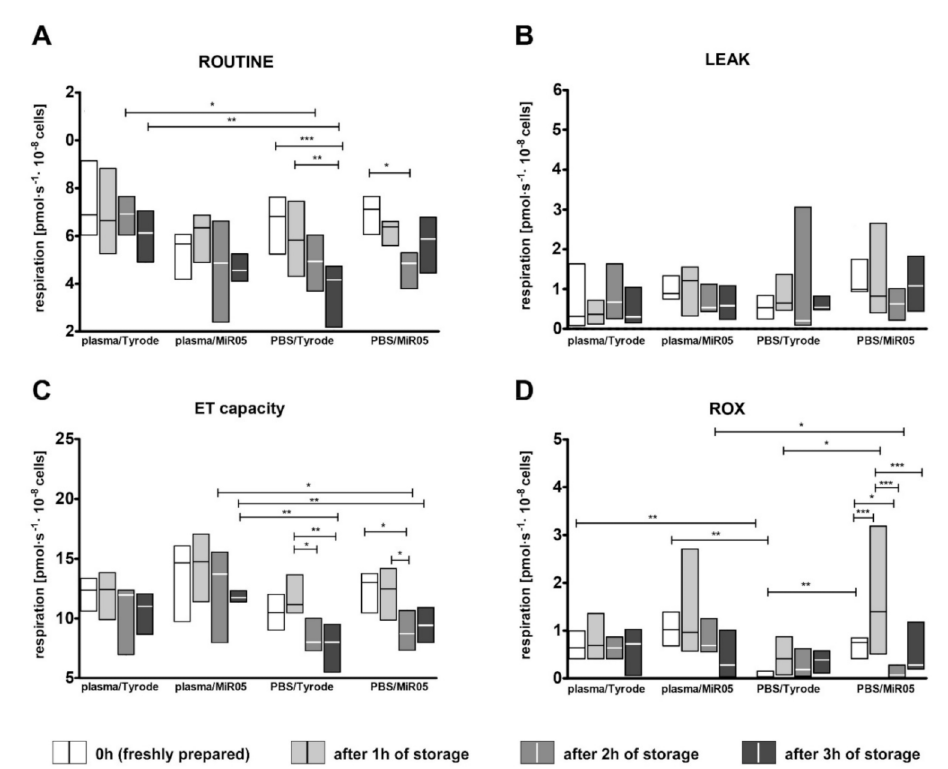
Figure 4. The effect of the storage of the platelet suspension on platelet mitochondrial and non-mitochondrial respiration in samples suspended in plasma or PBS and transferred to MiR05 or Tyrode’s buffer at the appropriate time point of storage. Data are presented as medians (solid line within boxes) and IQRs (boxes); n = 6. ROUTINE respiration ( A ), LEAK ( B ), ET capacity ( C ), and ROX ( D ) were measured for freshly prepared platelet suspensions and after one, two, and three hours of storage. The significance of differences, as estimated with two-way ANOVA for repeated measures with post hoc Tuckey test was: * p < 0.05, ** p < 0.01, *** p < 0.001. Additional information on the effect of time, the effect of medium and the effect of buffer are presented below: ( A ) p < 0.01 for the effect of time, p < 0.01 for the medium-depended buffer effect, ns. for the effect of medium, ns. for the effect of buffer; ( B ) ns. for the effect of time, ns. for the effect of medium, ns. for the effect of buffer; ( C ) p < 0.05 for the effect of medium, p < 0.001 for the effect of time, ns. for the effect of buffer; ( D ) p < 0.05 for the effect of time, p < 0.05 for the effect of medium p < 0.01 for the effect of time depending on medium ns. for the effect of